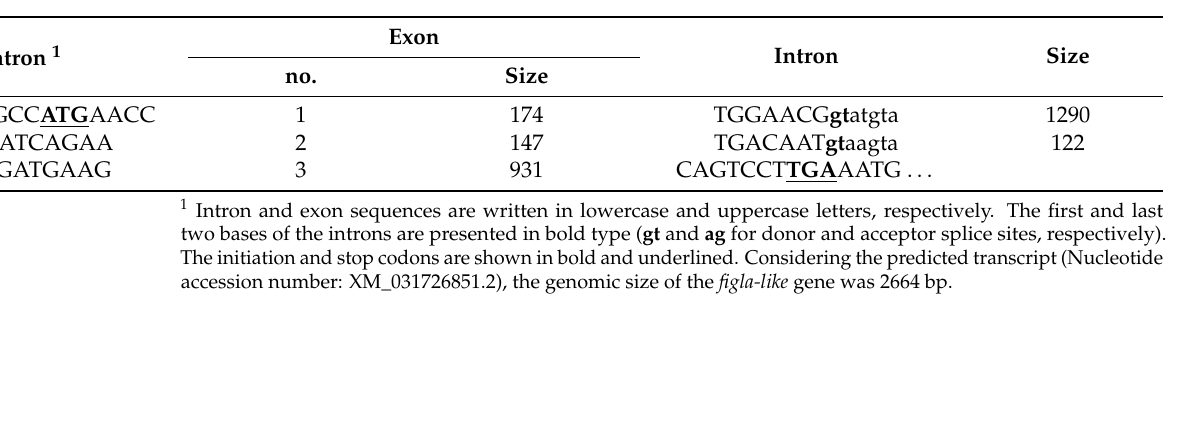
Table 2. Genomic organization of the figla-like gene in O. aureus